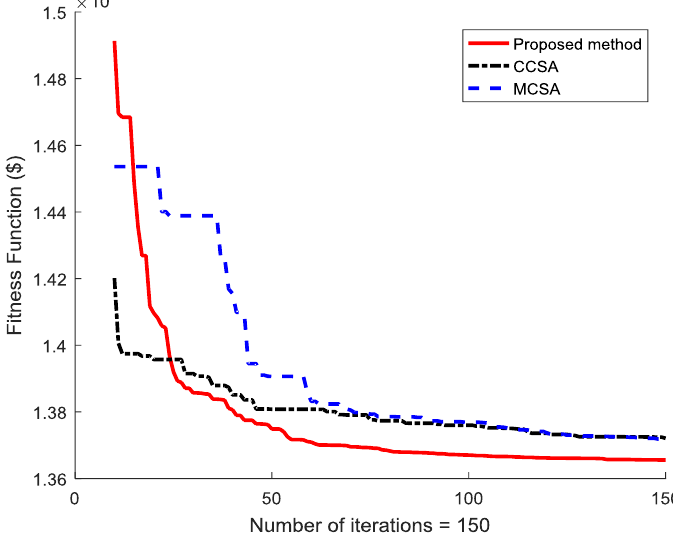
Figure 3. Fitness function convergence characteristics for the IEEE 30 buses system.